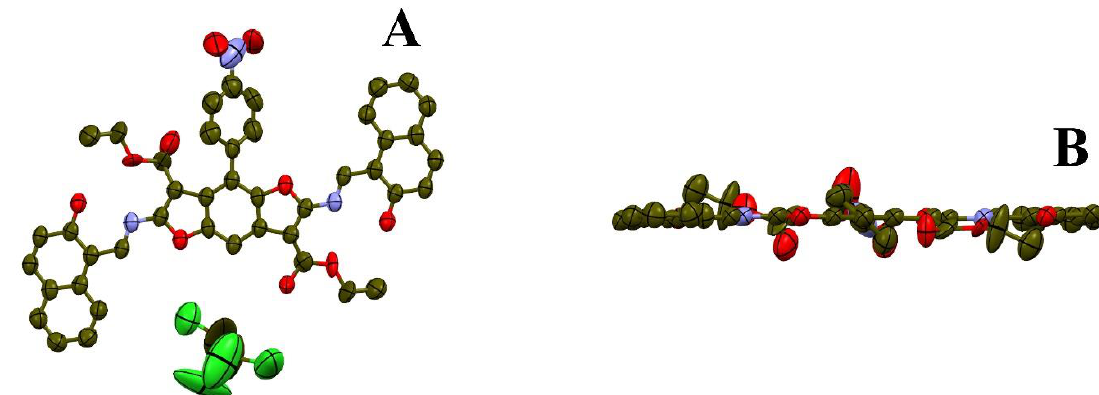
Figure 5. A : molecular structure of NBDF C 2 H 2 Cl 4 . Thermal ellipsoids representation of atoms is